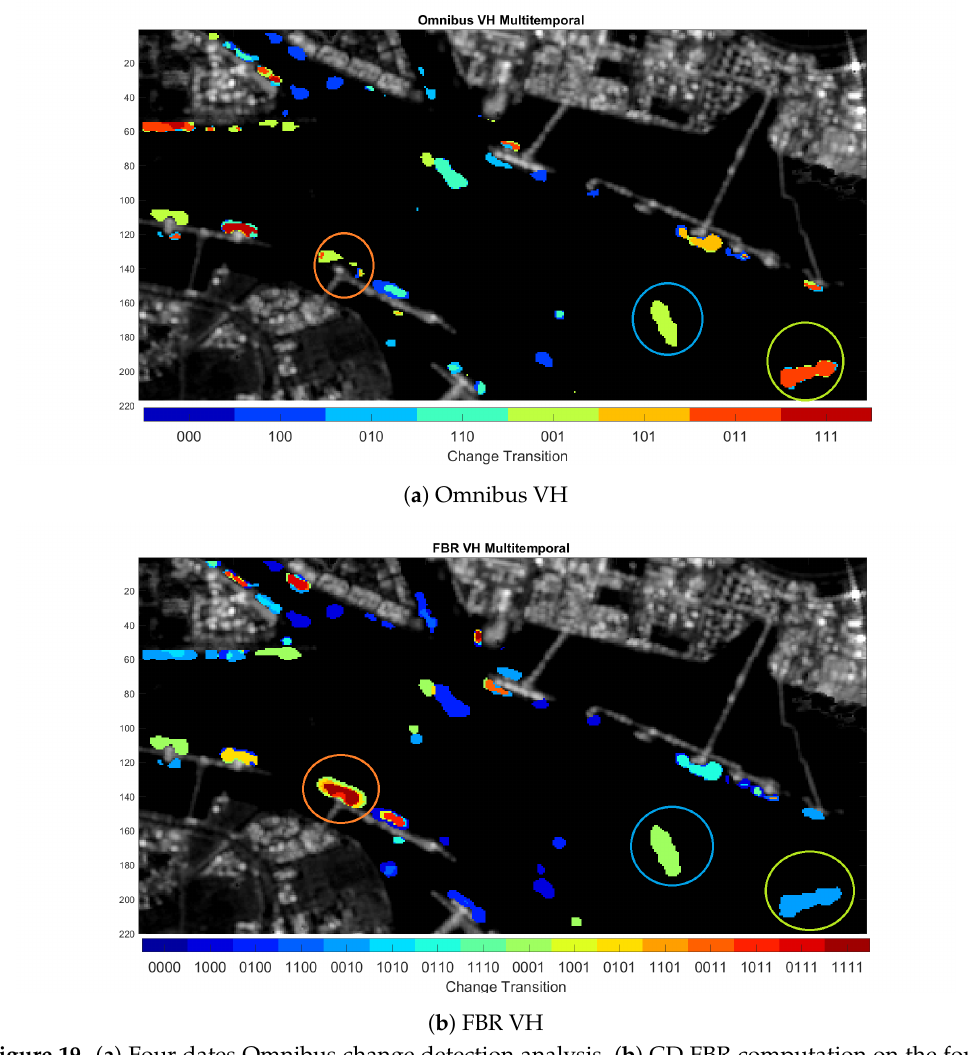
Figure 19. ( a ) Four dates Omnibus change detection analysis, ( b ) CD FBR computation on the four first